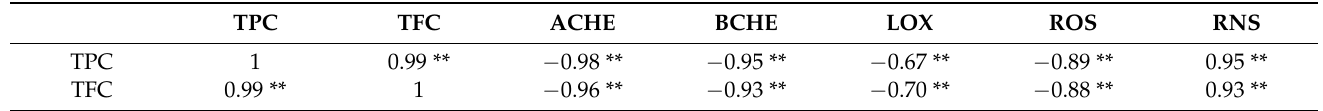
Table 4. Correlations among the TPC, TFC and neuroprotective potential values of PLE thinned peach